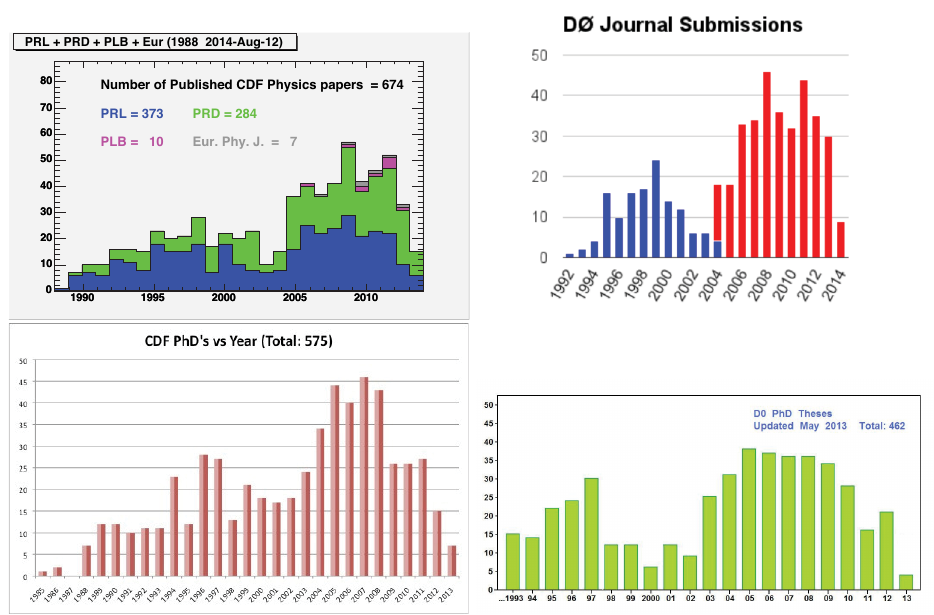
Figure 11. The Tevatron legacy in